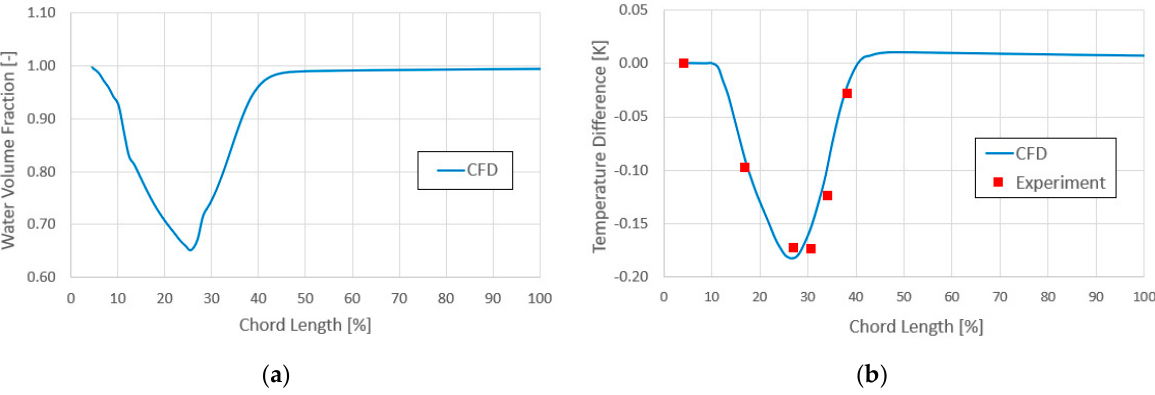
Figure 11. Comparison of numerical and experimental results on upper side of hydrofoil, σ = 1.9. ( a ) Distribution of water volume fraction; ( b ) temperature difference related to the first thermistor probe